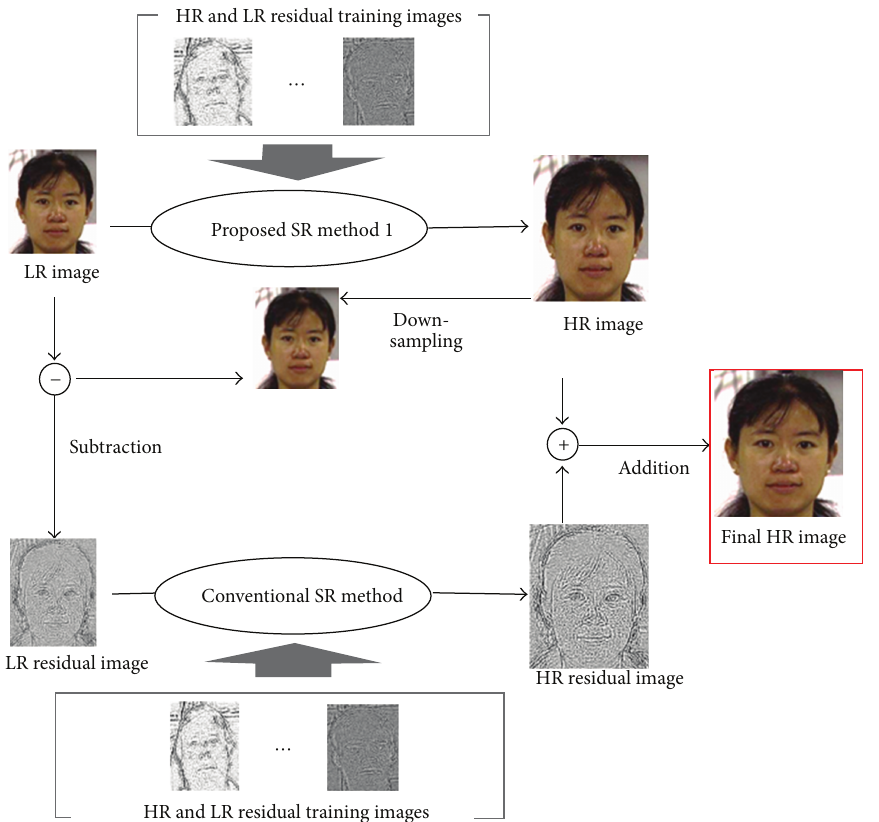
Figure 5: Proposed super resolution method